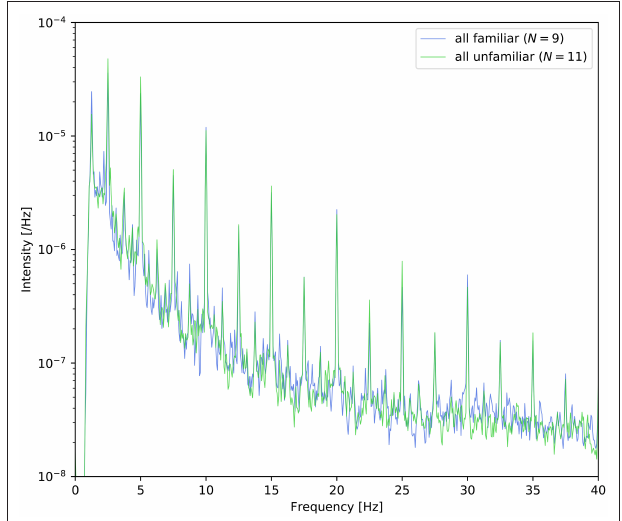
FIGURE 2 | Power density spectra of the envelope averaged across the nine tunes for which all participants answered “familiar” and the eleven tunes for which all participants answered “unfamiliar.”